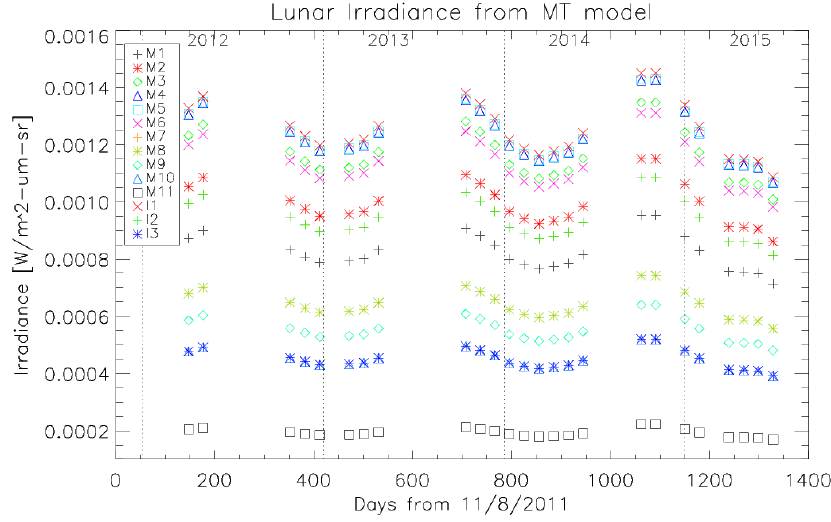
Figure 7. Lunar irradiance calculated with Miller and Turner (MT) model at the center time of VIIRS scheduled lunar collections.